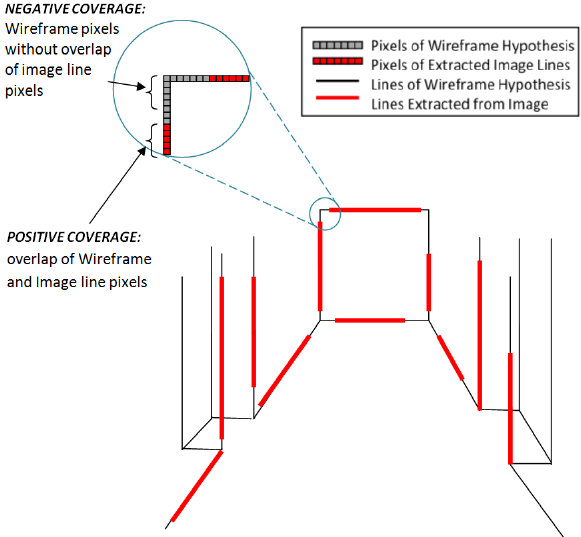
Figure 6. Positive and Negative Coverage for Indoor